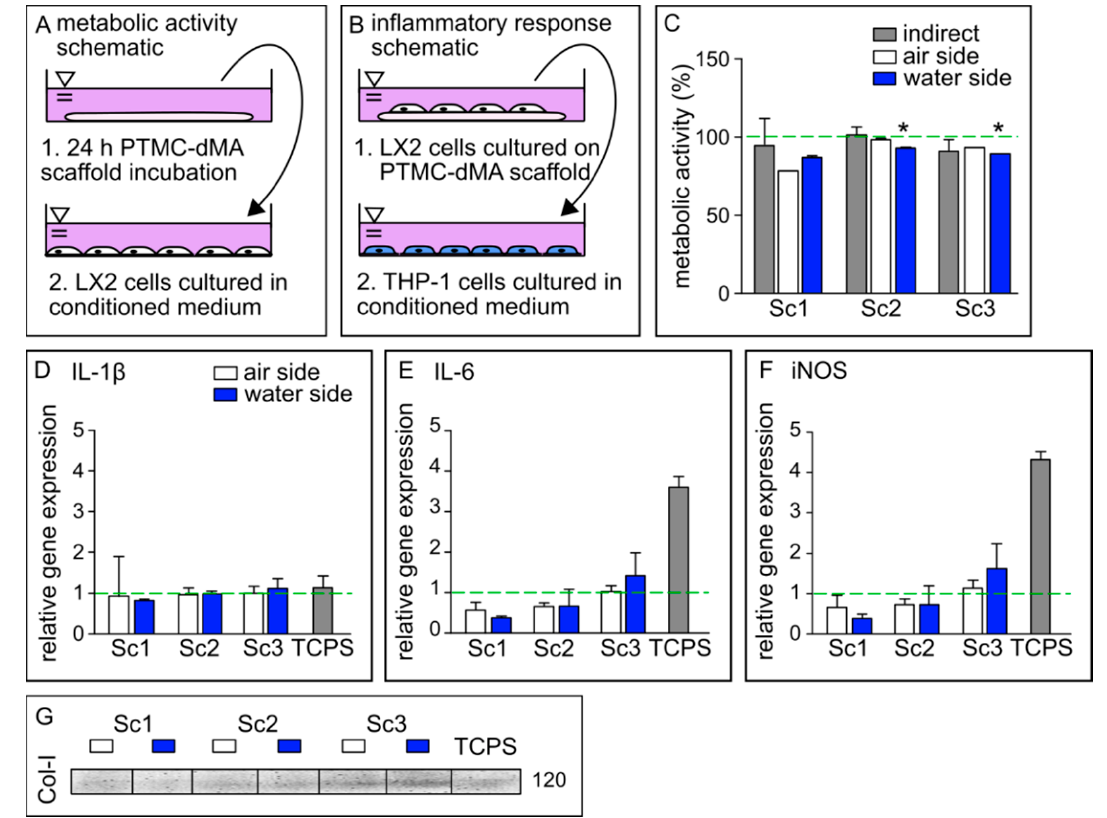
Figure 5. PTMC-dMA scaffolds are biocompatible and induce extracellular matrix formation. Schematics of conditioned medium used in ( A ) metabolic activity assays and ( B ) inflammatory response assays. ( C ) Metabolic activity of LX2 cells under various culture conditions after 24 h. The dashed green line indicates 100% metabolic activity of the control cells cultured on TCPS without conditioned medium. * p < 0.05 versus the TCPS control. Relative gene expression of ( D ) IL-1 β , ( E ) IL-6 and ( F ) iNOS in M0 macrophages cultured in conditioned medium. The dashed green line indicates the relative gene expression found in M0 macrophages cultured in normal medium as a control. ( G ) Western blot of collagen 1 (Col-I) production of LX2 cells under various conditions. TCPS is the control of LX2 cells cultured on TCPS without conditioned